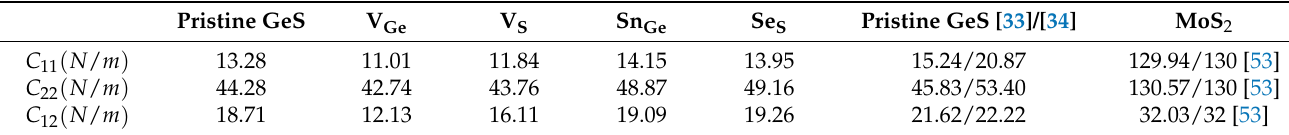
Table 2. Elastic coefficients for pristine GeS, GeS with vacancies (V Ge , V S ), and GeS with substitutional atoms (Sn Ge , Se S ) compared with previous studies for pristine GeS and MoS 2 .